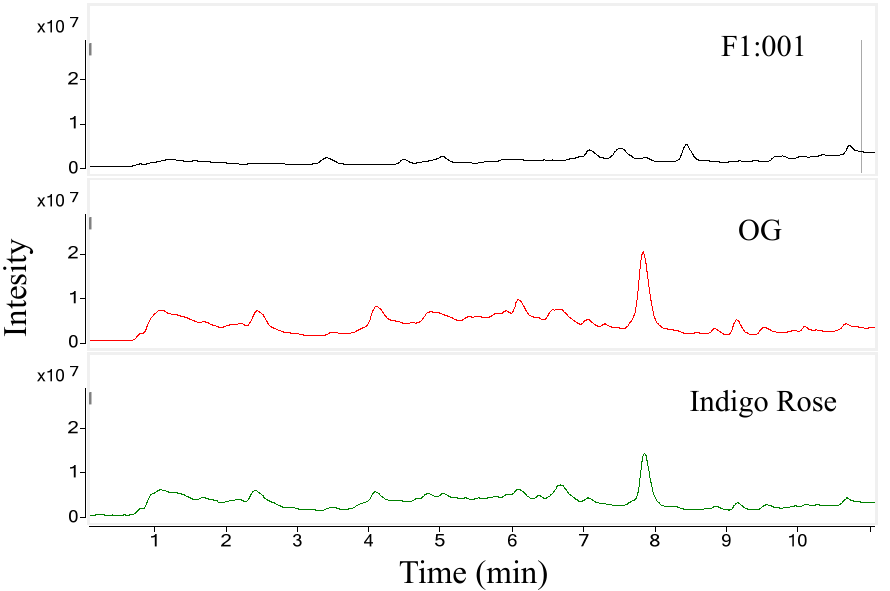
Figure 2. Chromatograms of [M+H]+ ions in three varieties of black cherry tomatoes. The study further analyzed anthocyanin composition in the three black cherry tomato varieties by the LC–MS/MS method and obtained the chromatogram of [M+H]+ ions in the retention time of 10 min. Based on the chromatograms and mass spectra of the collected ions, combined with references to anthocyanin compounds that have been detected in a variety of fruit and vegetable materials, especially in black cherry tomatoes, the study analyzed the chromatogram of each [M+H]+ ion that was separated. Based on their structures, three different aglycones were obtained, including delphinidin ( m / z 303) with three derivatives, petunidin ( m / z 317) with two derivatives and malvidin ( m / z 331) with one derivative (Table